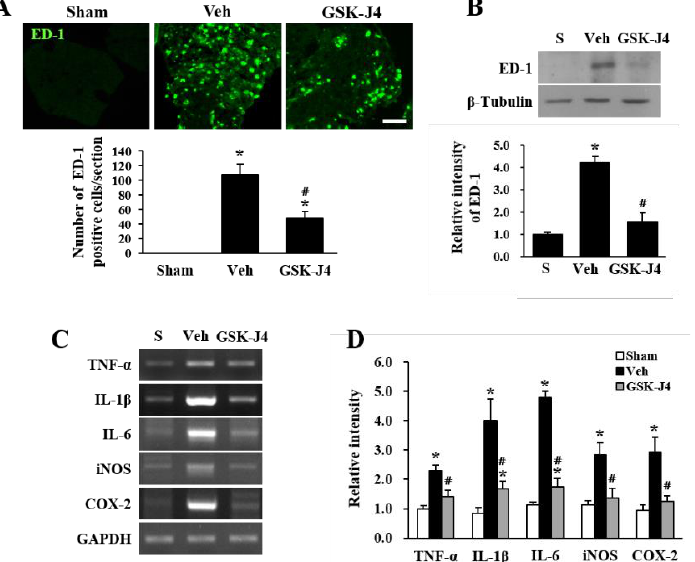
Figure 4. The Jmjd3 inhibitor reduced macrophage infiltration and inflammation in the injured cauda equina of LSS rats. ( A ) Immunofluorescence staining for ED-1 in Sham, vehicle- or GSK-J4-injected rat at 30 min after treatment (upper panel). Quantitative analysis of the number of ED-1 positive cells per section. The data are presented as the mean ± SD (n = 3). * p < 0.05 vs. Sham; # p < 0.05 vs. Vehicle. Scale bar, 50 μm. ( B ) Western blot and quantitative analysis for ED-1 30 min after vehicle or GSK-J4 treatment. The data are expressed as the mean ± SD (n = 3). * p < 0.05 vs. Sham; # p < 0.05 vs. Vehicle. ( C ) RT-PCR for TNF- α, IL - 1β, IL -6, iNOS, and COX-2 in the cauda equina 30 min after vehicle or GSK-J4 treatment. ( D ) Quantitative analysis of RT-PCR. The data are expressed as the mean ± SD (n = 3). * p < 0.05 vs. Sham; # p < 0.05 vs. Vehicle.